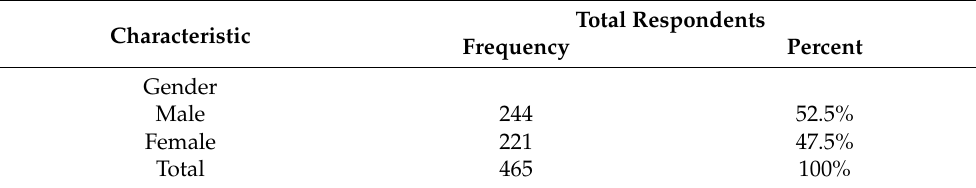
Table 2. Demographic characteristics of